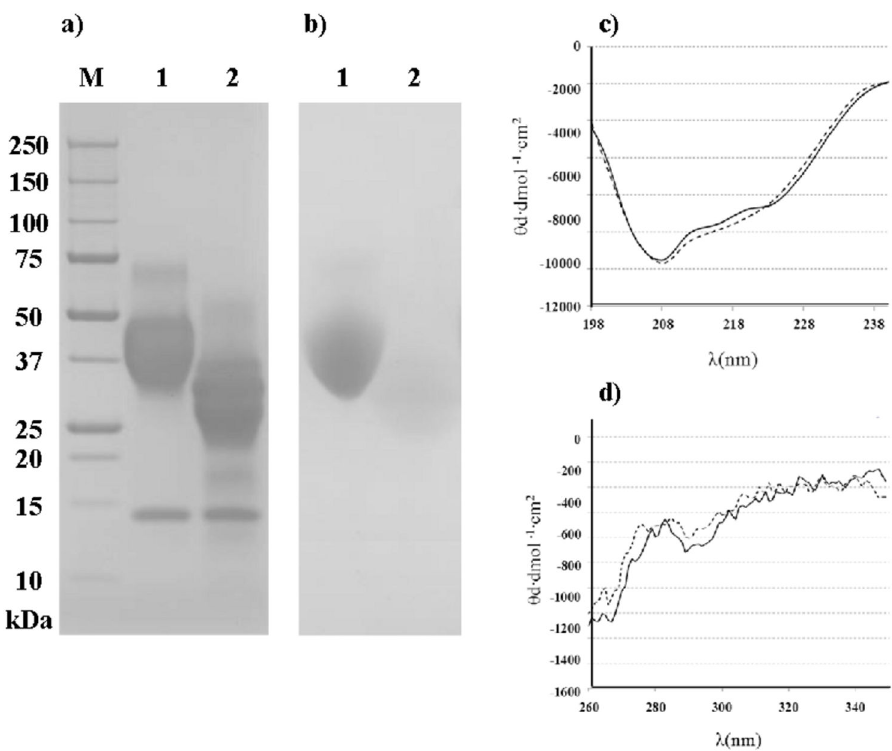
Figure 1. OM deglycosilation results. SDS-PAGE patterns of OM and its deglycosylated form (dOM) with Coomassie blue (a) or PAS (b) staining M: molecular mass marker; 1: OM, 2: dOM. Circular dichroism spectra in the far (c) and near (d) UV region of OM (−) and dOM (---). The spectra were recorded in phosphate buffer, pH 7.0, at 20°C. doi: